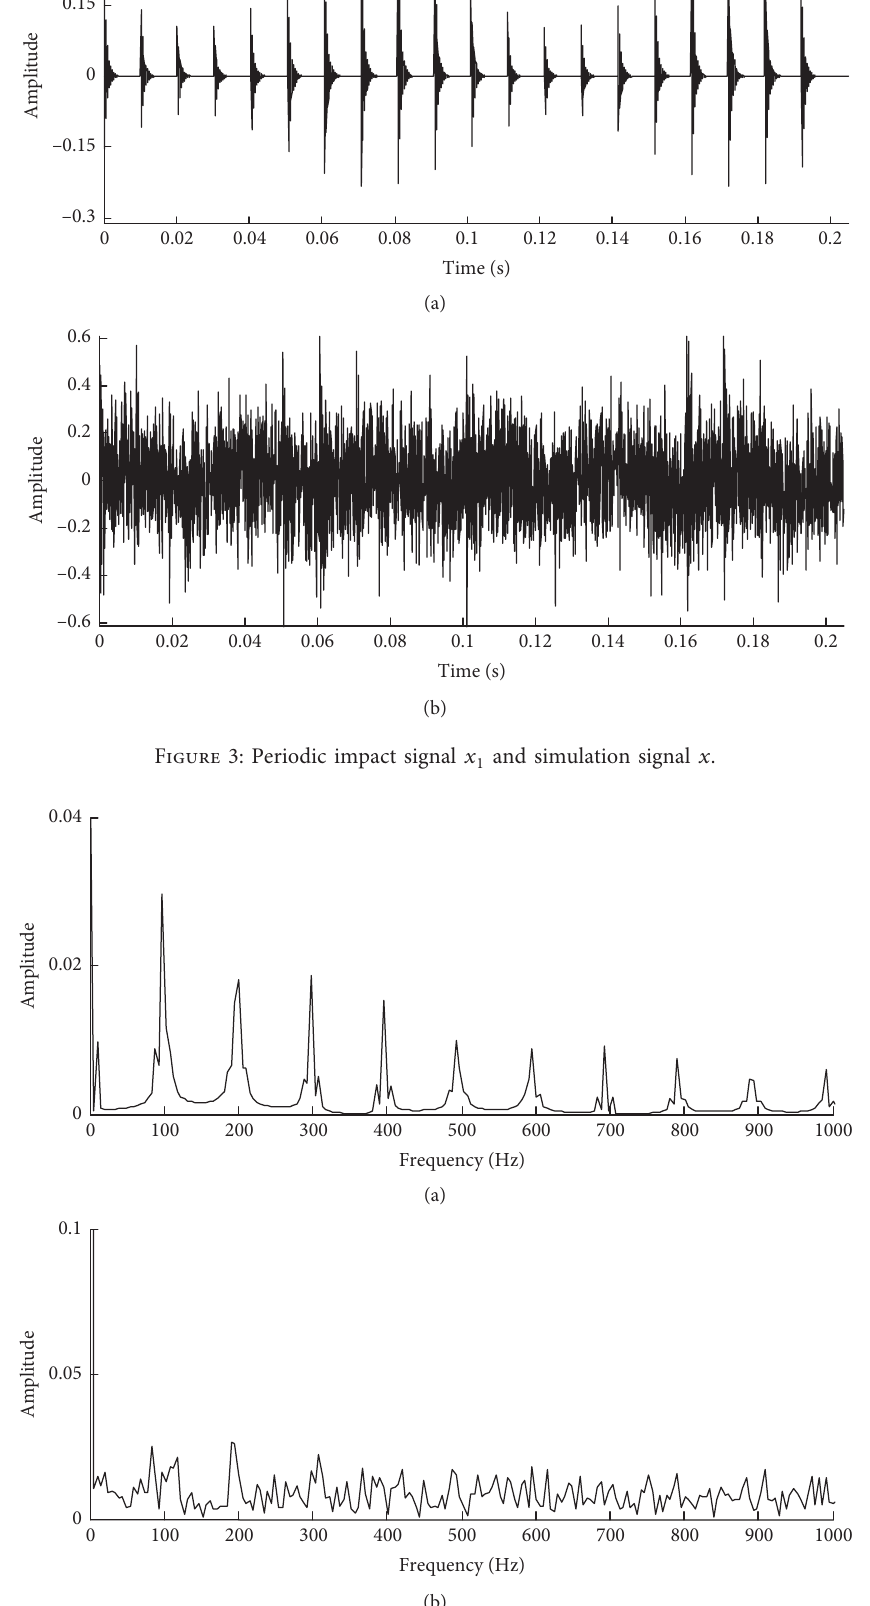
Figure 4: Hilbert envelope spectrum of x